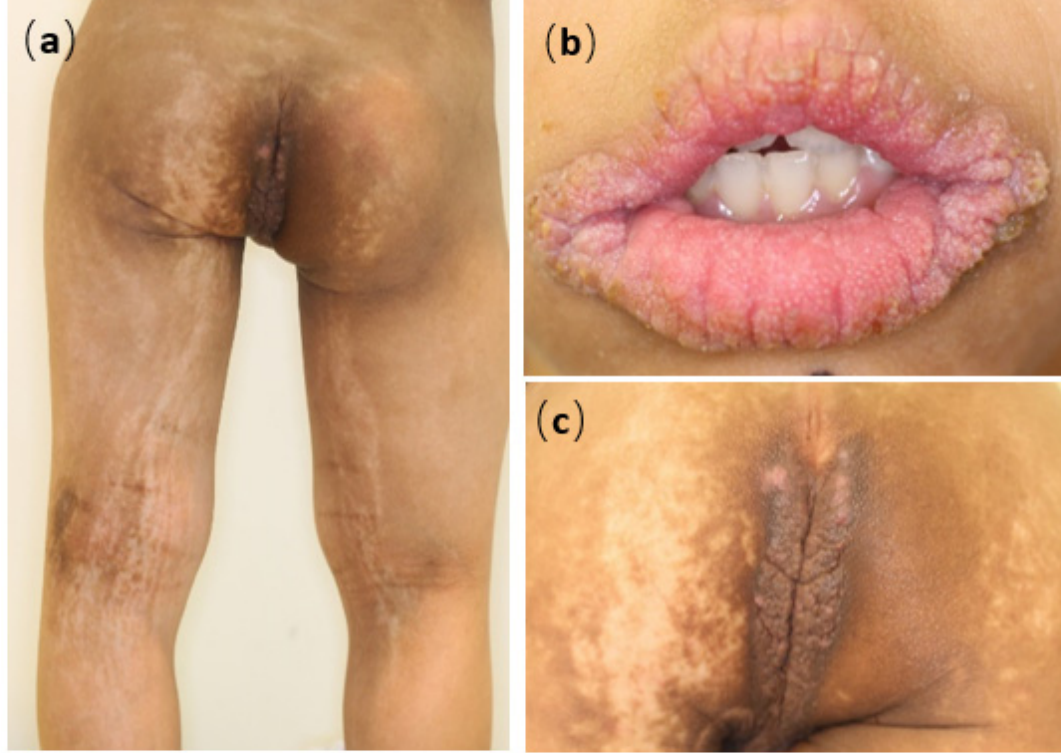
Figure 1. Clinical features of this patient: widespread brown macules and white plaques along Blaschko’s lines ( a ) with mammillated lesions of the lip ( b ) and brownish papillomatous plaques in the perianal region ( c ).